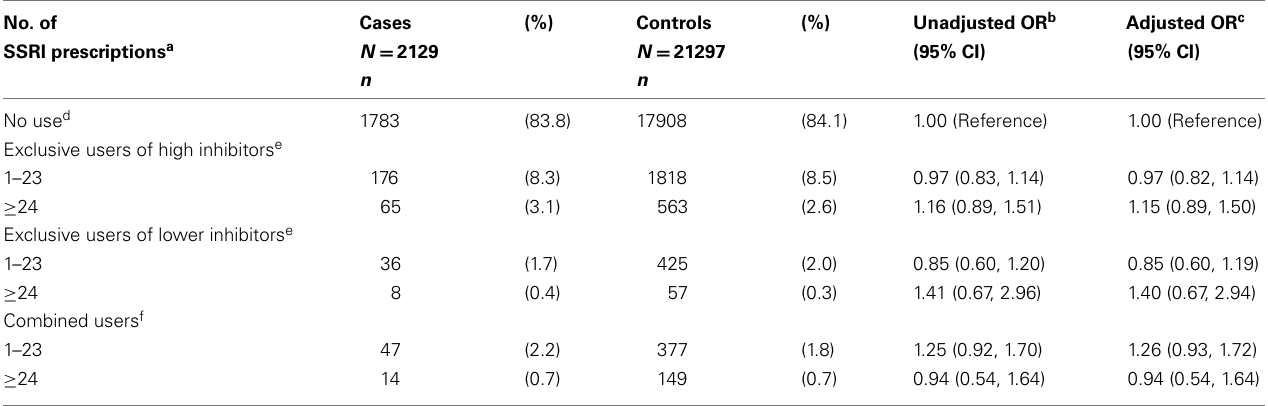
Table 3 | Odds ratios for breast cancer according to the duration of selective serotonin reuptake inhibitor (SSRI)